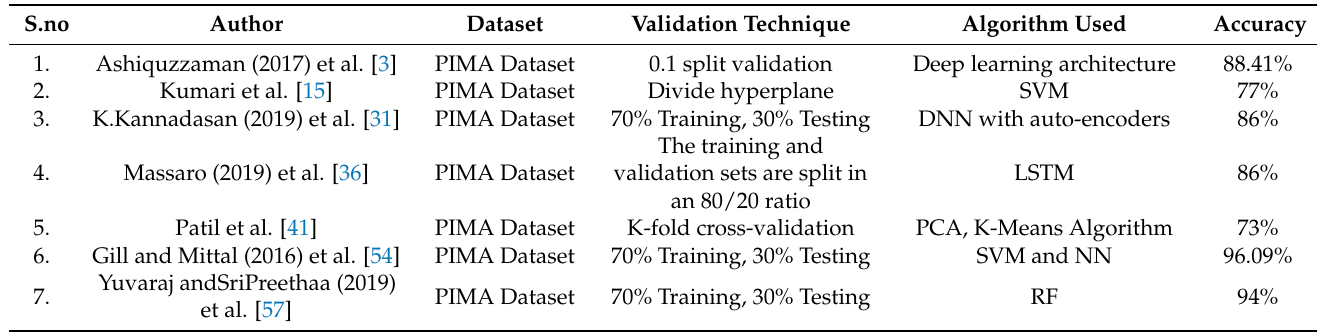
Table 14. Comparison of our model with other state-of-the-art algorithms in terms of accuracy mentioned in related